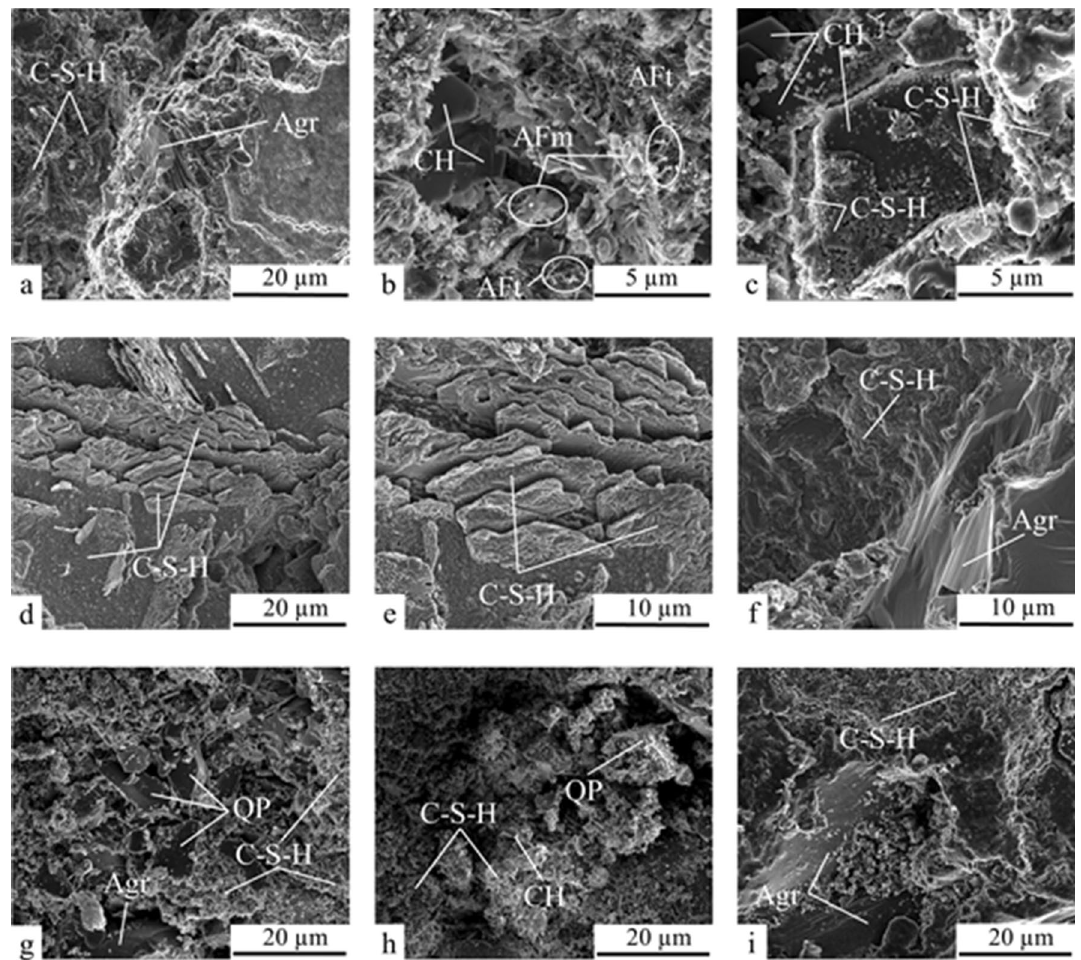
Figure 7. SEM ( a – c ) analysis of RC, ( d – f ) SFC and ( g – i ) QPC. Note: AFm—monosulfate; AFt—ettringite; Agr—fine aggregate; CH—calcium hydroxide; C–S–H—calcium silicate hydrate; and QP—quartz powder.